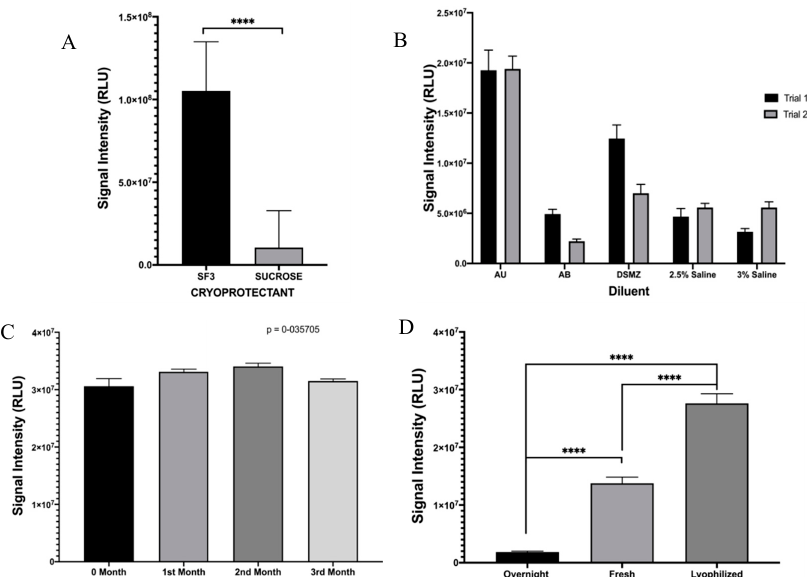
Figure 3. Optimization of lyophilized cells of P. leiognathi . Bioluminescence activity was assessed following ( A ) exposure to cryoprotectant (**** p ≤ 0.0001) or ( B ) varying diluent composition. ( C ) Bioluminescence of lyophilized cells using SF3 cryoprotectant was determined over 3 months, while ( D ) the normalized signal from overnight / fresh / lyophilized cultures of P. leiognathi was compared (**** p ≤ 0.0001).